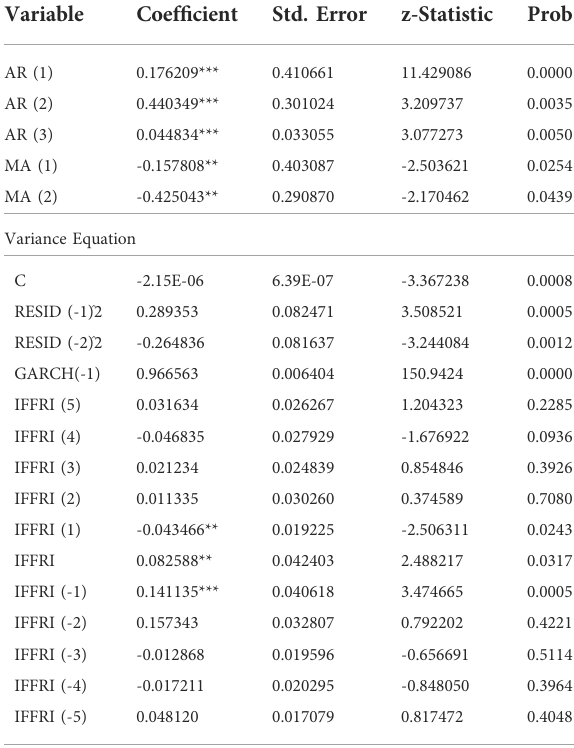
TABLE 6 ARMA-GARCH model result (IFFRI factor is not added). TABLE 7 ARMA-GARCH model result (IFFRI factor is